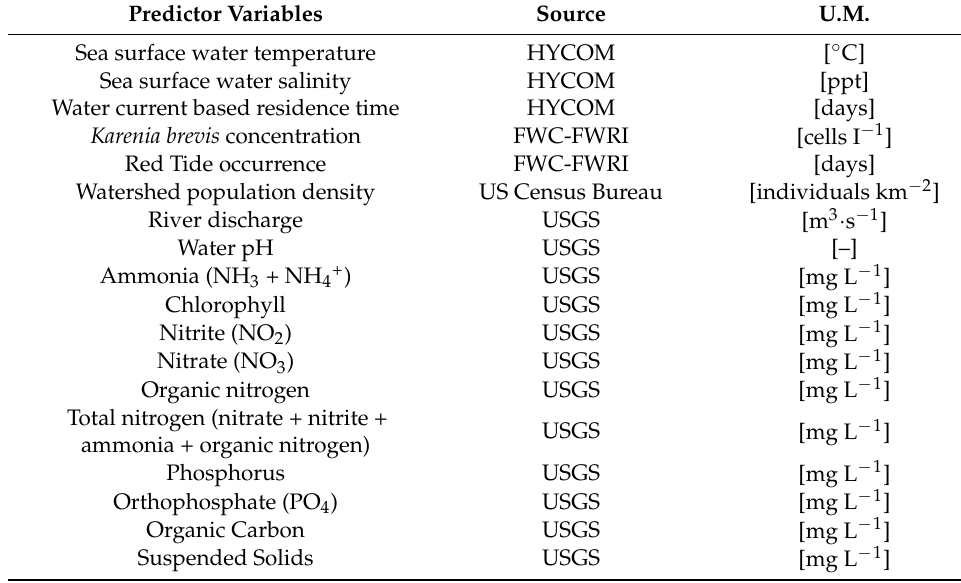
Table 1. Water quality and hydrodynamics predictor variables contained in the table were used in the linear regression analysis to find a relationship with the FP prevalence values. The columns contain, in order, the name, the source, and the unit of measurement (U.M.) of the predictors. Predictor